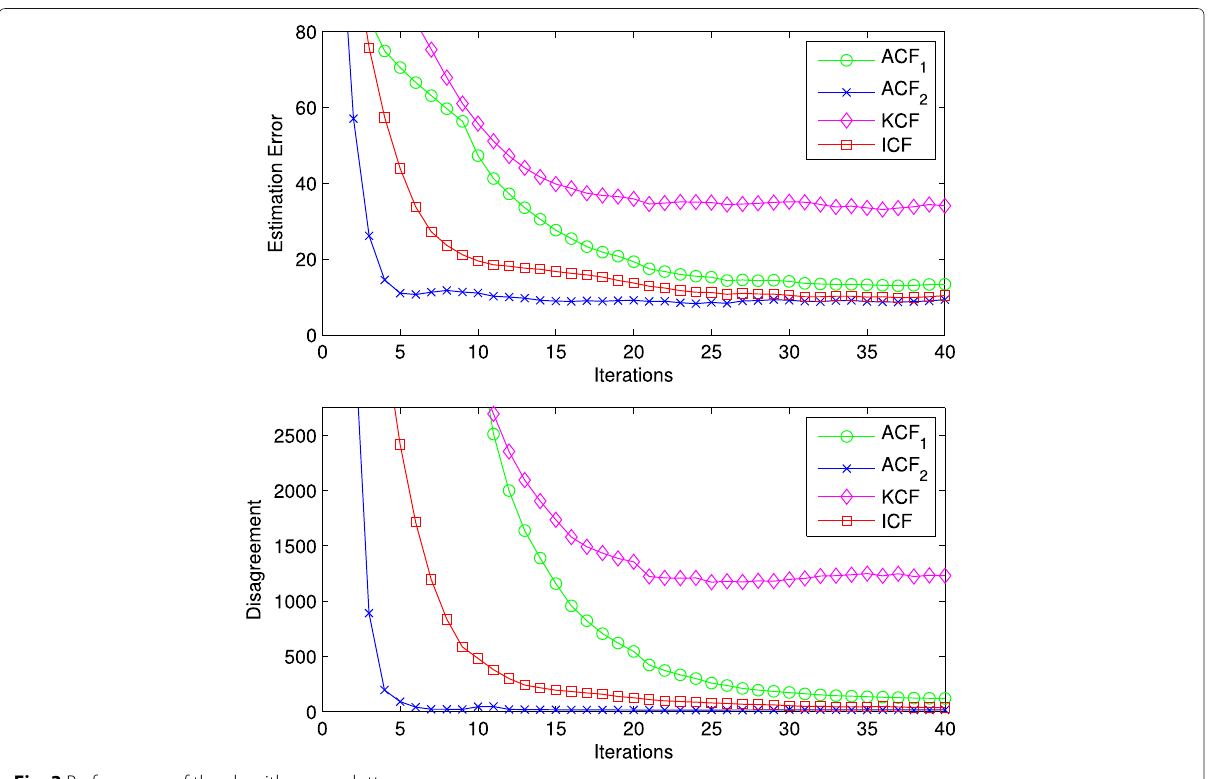
Fig. 3 Performance of the algorithms: no clutter